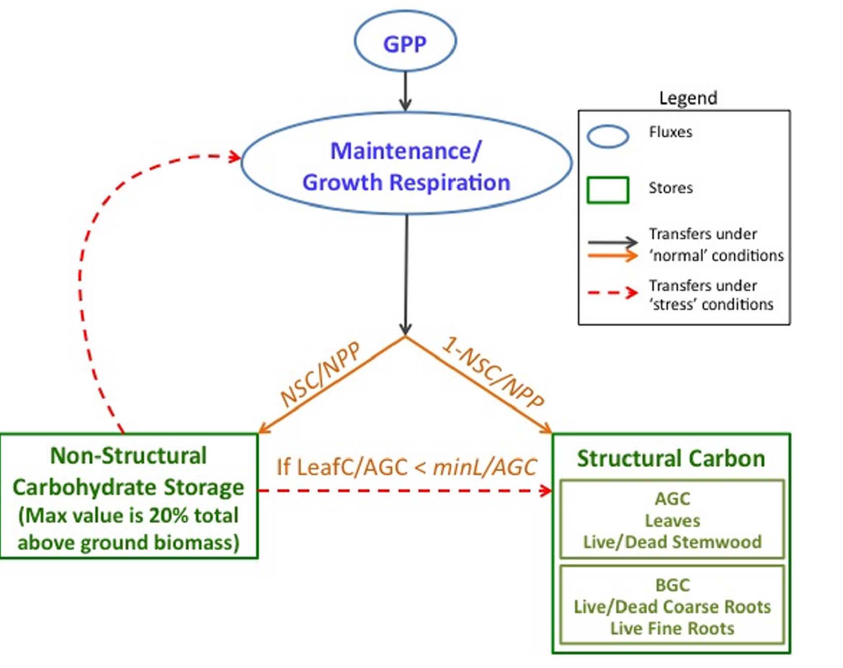
Figure 1. RHESSys submodel of allocation to NSC (non structural carbohydrate), with associated parameters. AGC is above ground plant structural carbon and BGC is below ground plant structural carbon. GPP is gross primary productivity. NSC/NPP is the fraction of annual NPP allocated to non-structural carbohydrate storage. MinL/AGC is defined as a threshold minimum for the ratio of leaf carbon (LeafC) to above ground carbon and determines when NSC will be depleted to maintain AGC.